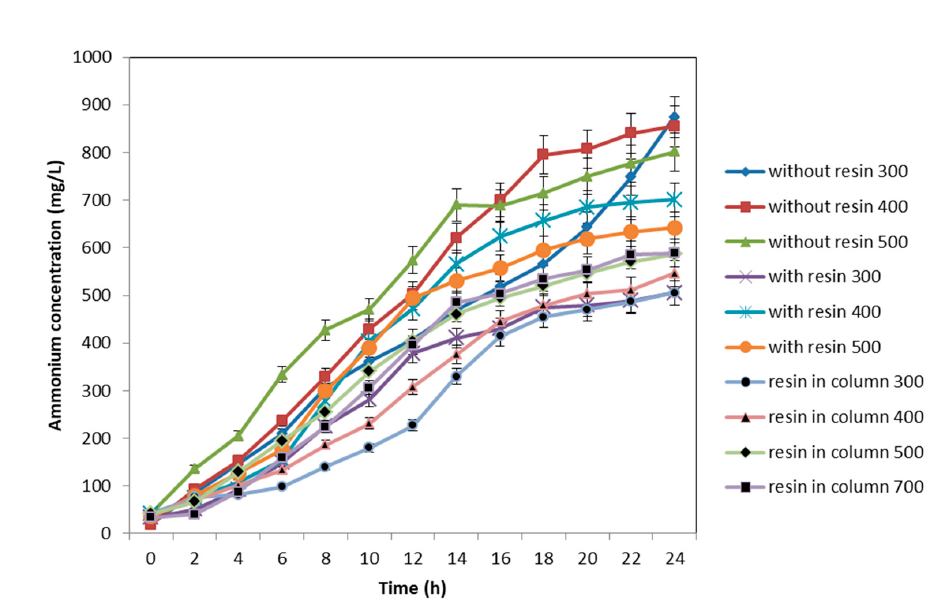
Figure 3. The time course of batch cultivation of gdhA derivative Pasteurella multocida B:2 with cell viability ( A ), glucose consumption ( B ), and ammonium concentration ( C ) in a 2 L stirred-tank reactor without the addition of resin, with dispersed Amberlite IRC 86 resin and Amberlite IRC 86 resin in internal column at different agitation speed.